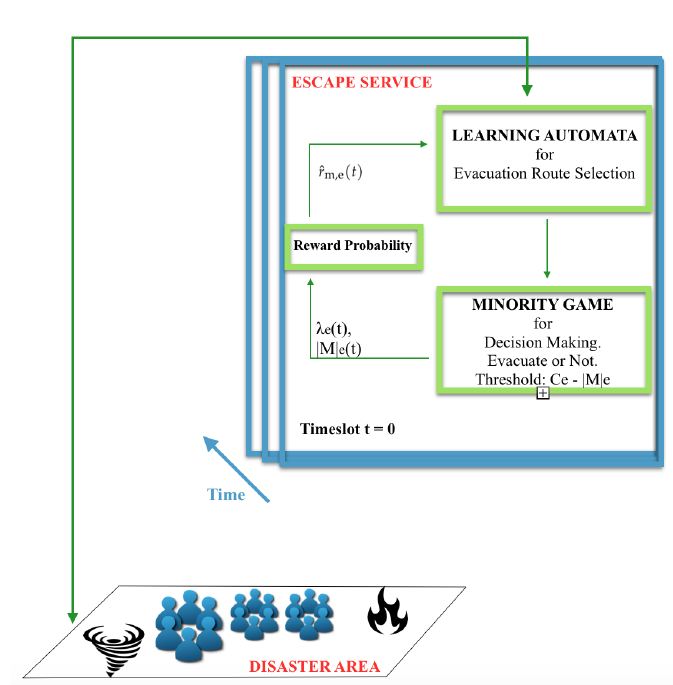
Figure 2. Autonomous evacuation-planning framework as a learning